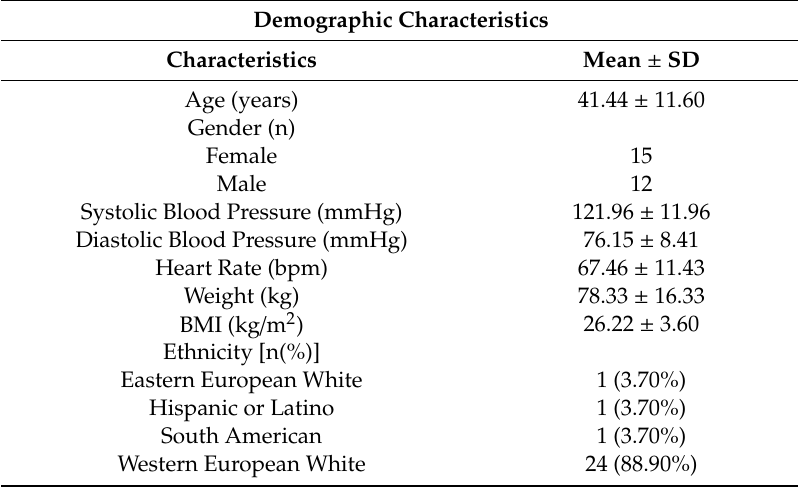
Table 2. Baseline characteristics for all participants enrolled ( n = 27).